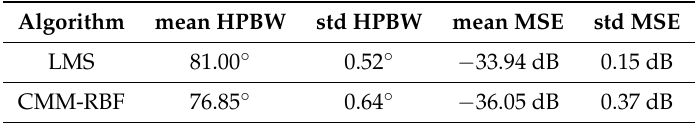
Table 1. Half-power beamwidth (HPBW) and mean squared error (MSE) statistical results for the uniform and circular array (UCA), varying the boresight angle from 0 ◦ to 360 ◦ .